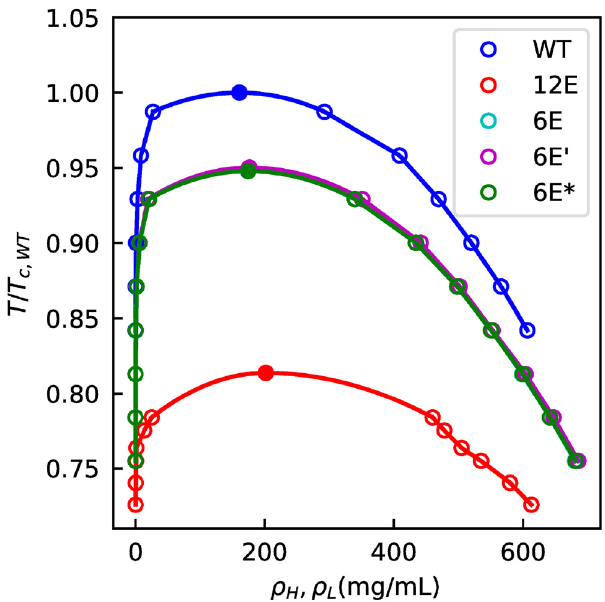
Fig 5. Phase diagram for FUS WT, 6E variants and 12E. Temperatures are scaled by the critical temperature of FUS WT.